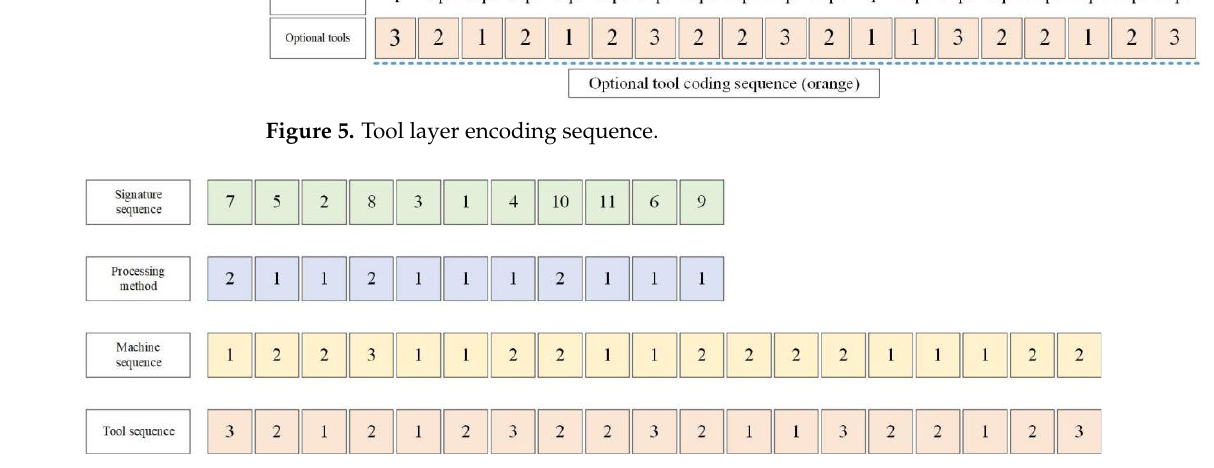
Figure 6. Four sequences of honeybee chromosomes.